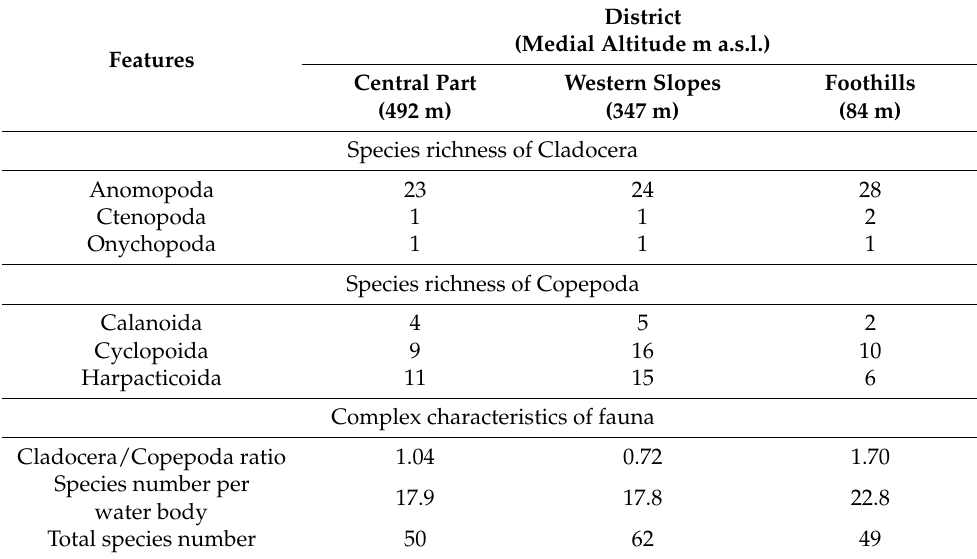
Table 1. Main characteristics of crustacean fauna from three areas of the Putorana Plateau in August 2021.